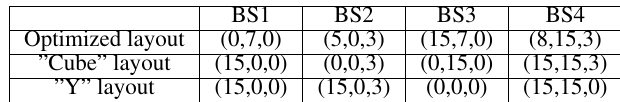
Table 1. Four base stations with different layout methods base-station coordinate table.